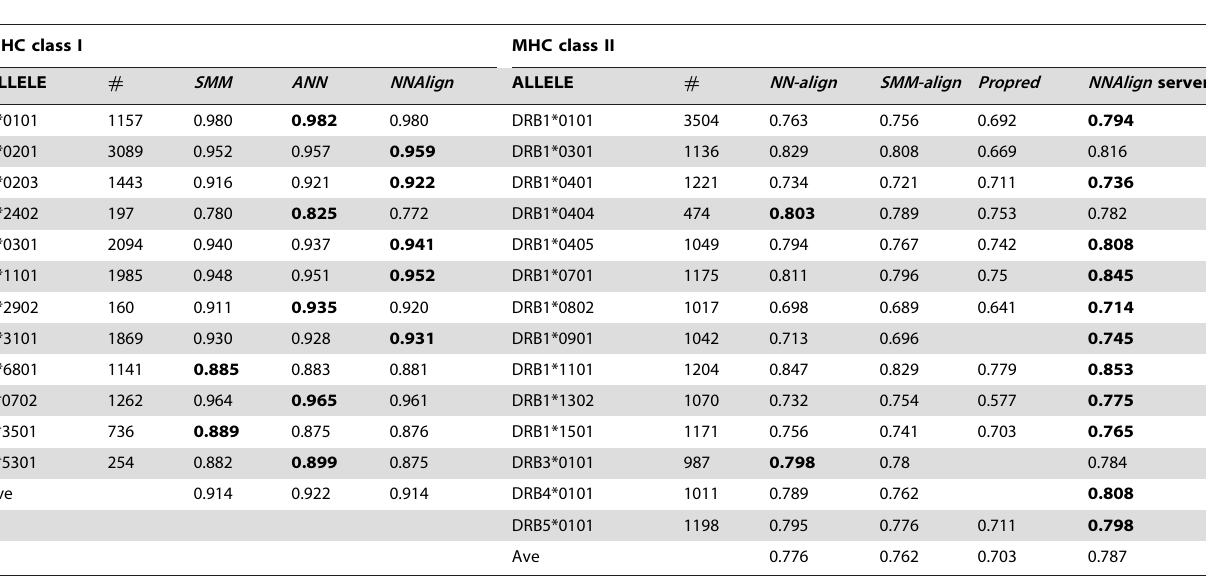
Table 1. Predictive performance in AUC on 12 human HLA MHC class I alleles (Peters data set) and on 14 HLA-DR MHC class II alleles (Wang similarity reduced SR